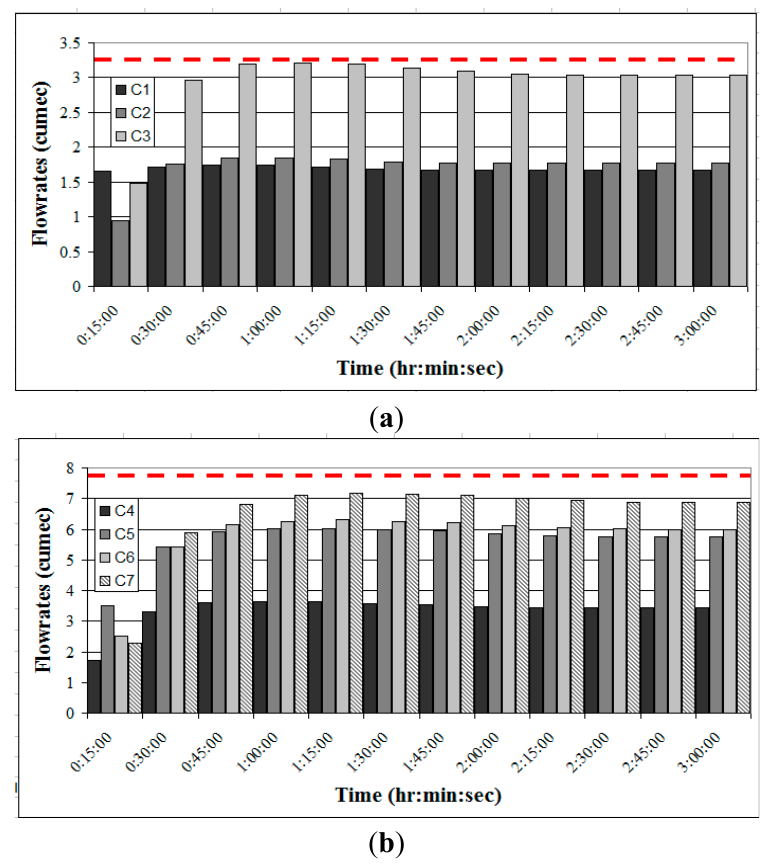
Figure 7. Flow rates in interceptor sewers. ( a ) C1 , C2 and C3 ; ( b ) C4 , C5 , C6 and C7